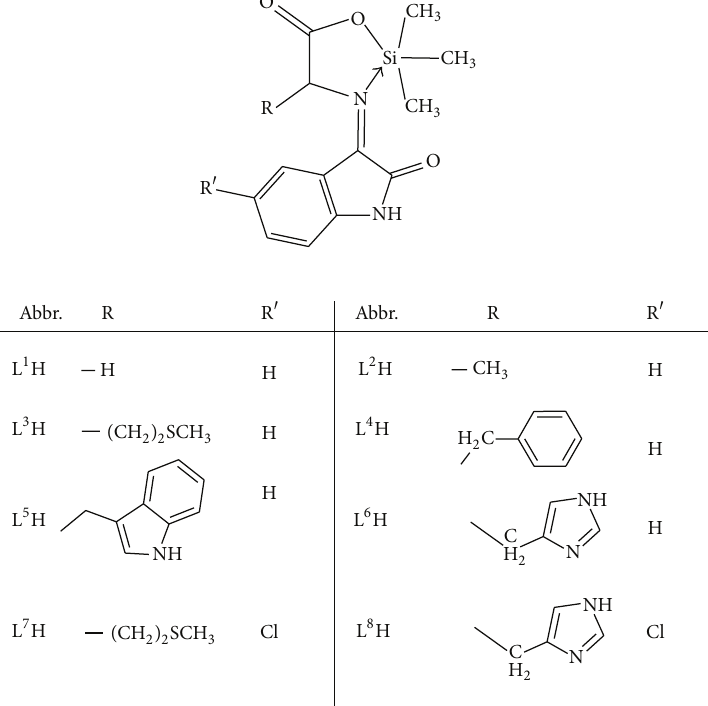
Figure 3: Structure of Organosilicon(IV)